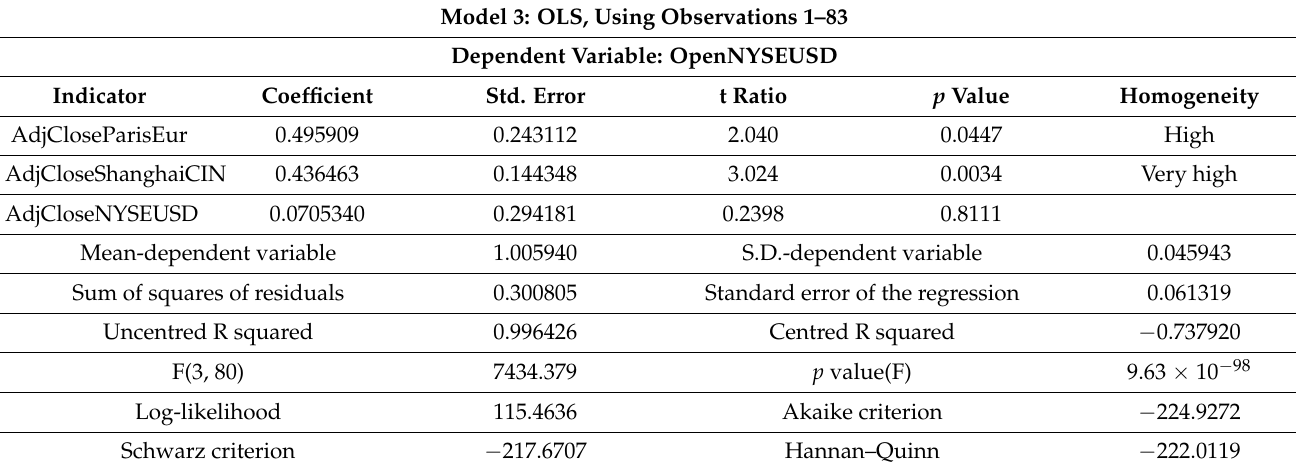
Table 6. Summary of the American volatility matrix model.